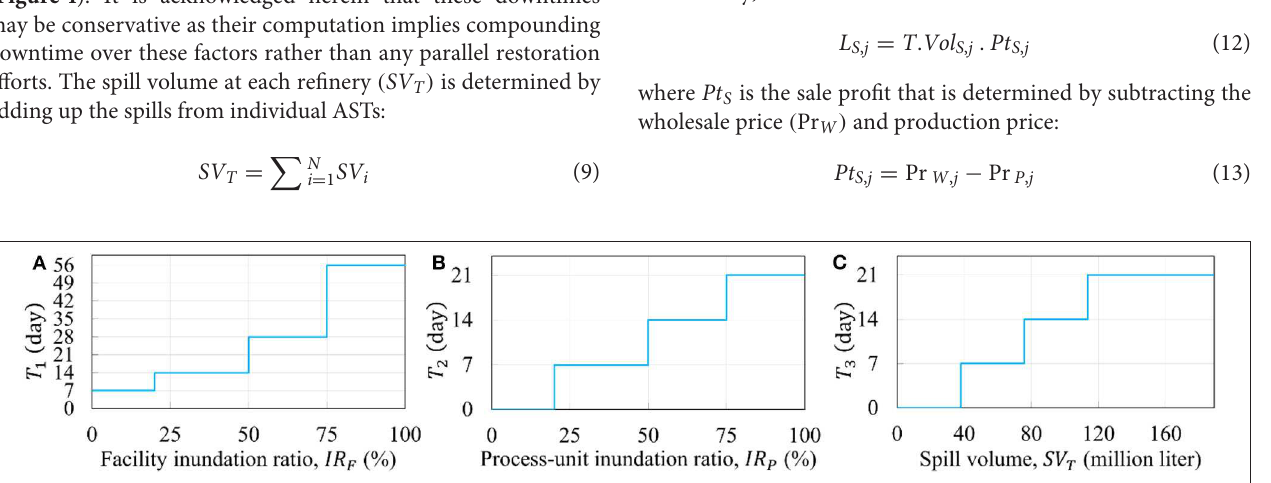
Frontiers in Built Environment |